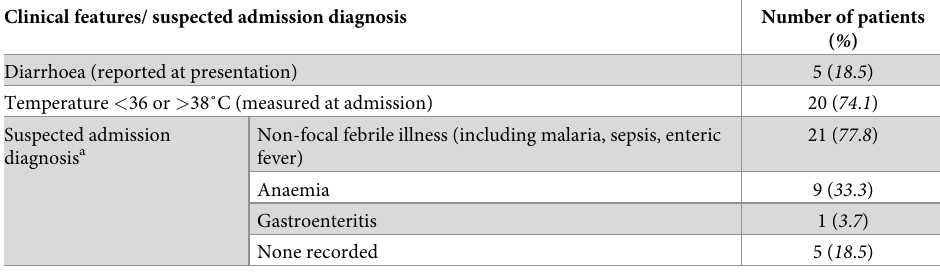
Table 1. Clinical features and suspected diagnoses of patients (n = 27) at admission. Clinical features/ suspected admission